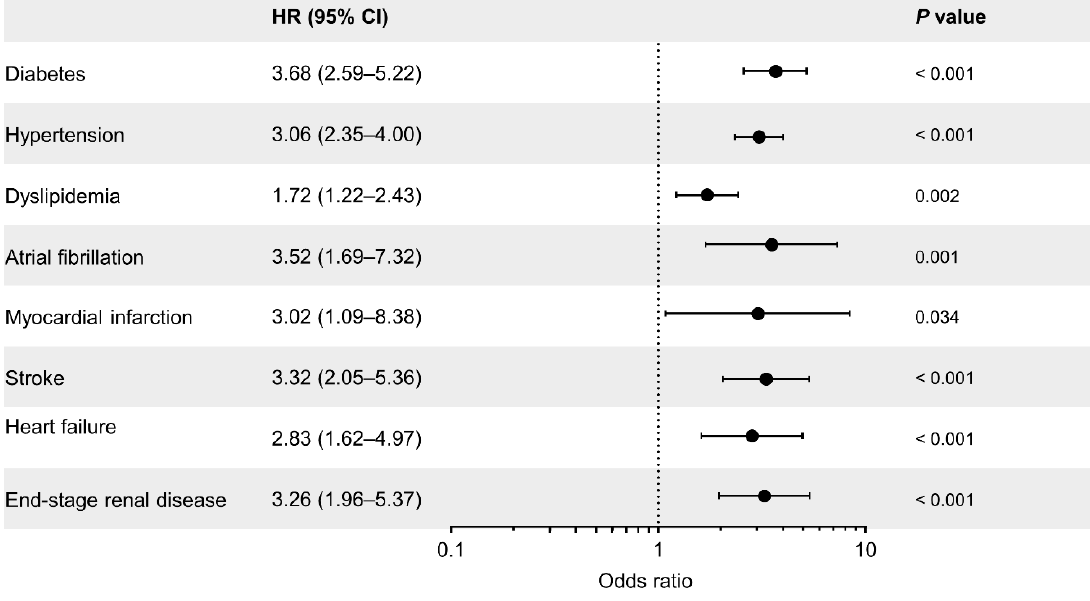
Figure 5. Odds ratio of a transfusion ‐ dependent status in thalassemia for comorbidities.